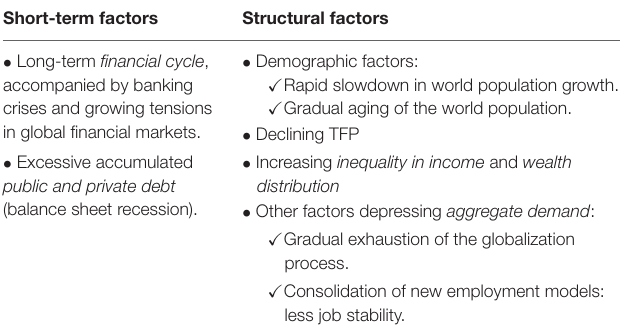
TABLE 1 | Explanatory factors of secular